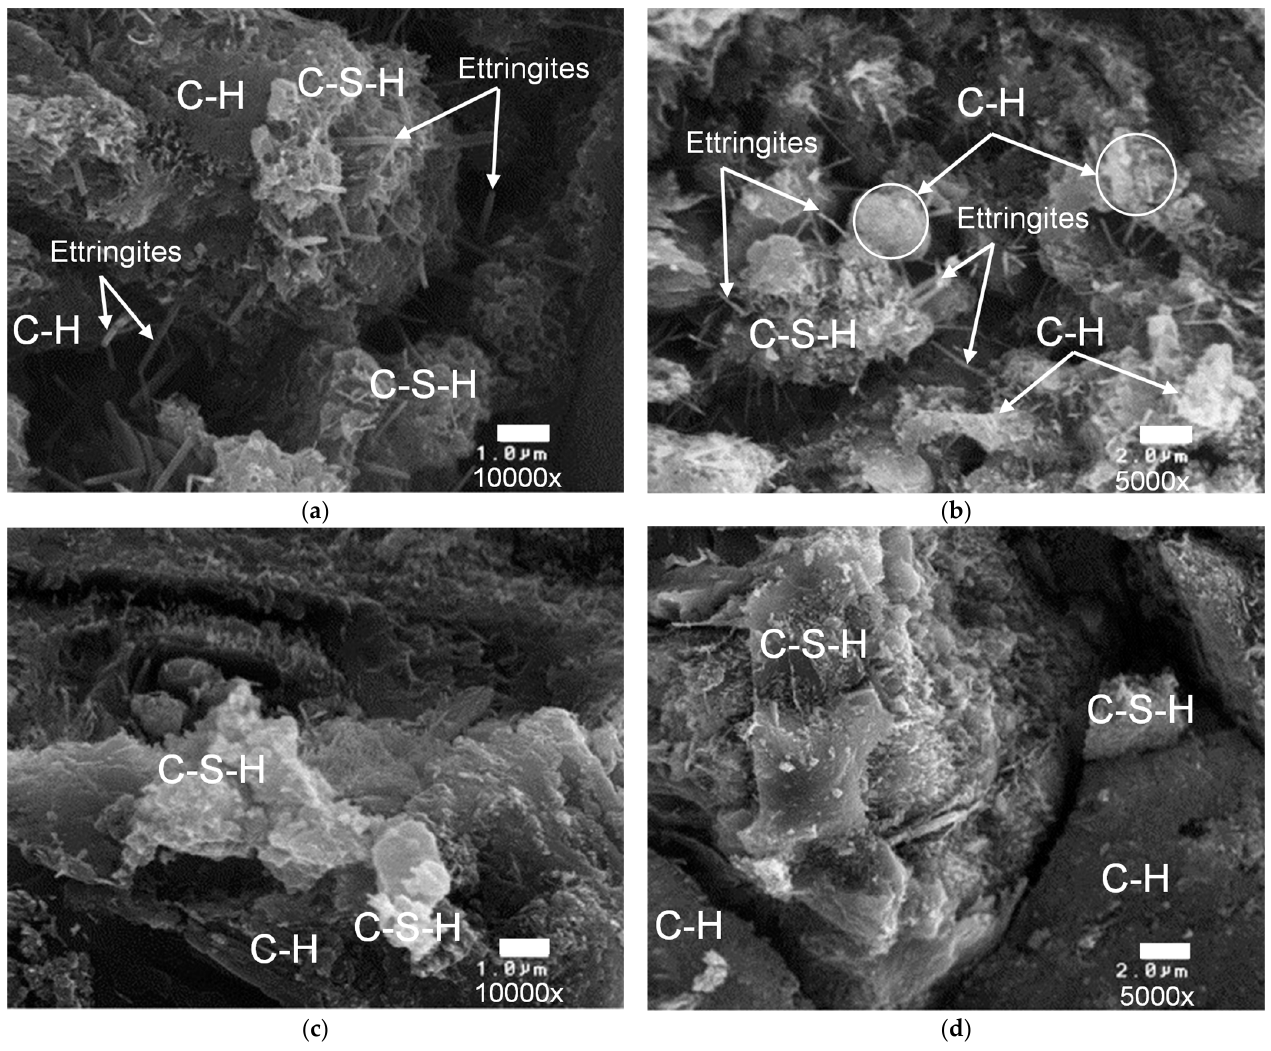
Figure 13. Microstructure of matrices: ( a ) cement paste 10,000×; ( b ) cement paste 5000×; ( c ) cement paste with NS 10,000×; ( d ) cement paste with NS 5000× [178]; CH: Ca(OH) 2 .